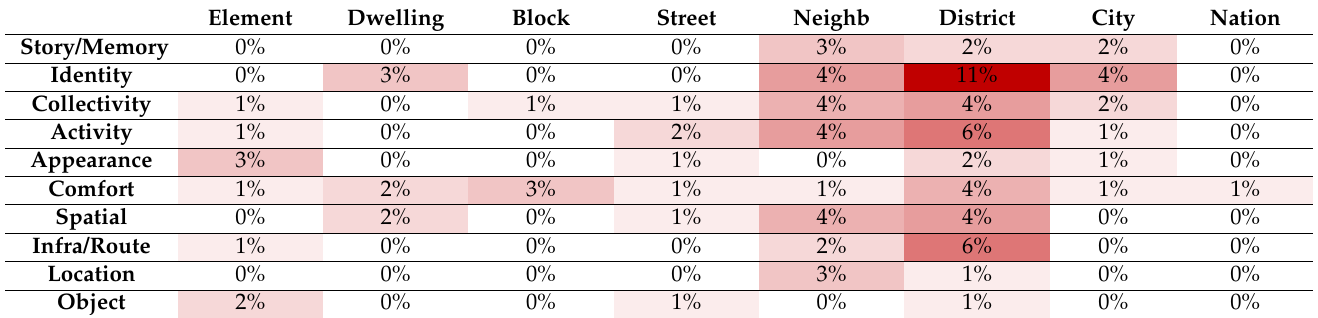
Table A5. Governments: two respondents.